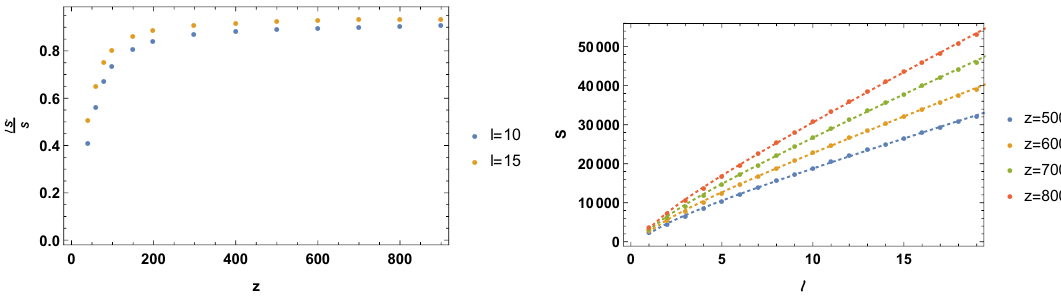
Figure 3 . Left : ‘S 0 as a function of z for di(cid:11)erent values of ‘ . For large values of z this quantity S approaches to a constant value exhibiting volume law behavior. right : (cid:12)tting data for EE as a function of ‘ according to eq. (3.1) for di(cid:11)erent values of z . Here we consider Dirichlet boundary condition for a massless scalar with N = 20000.